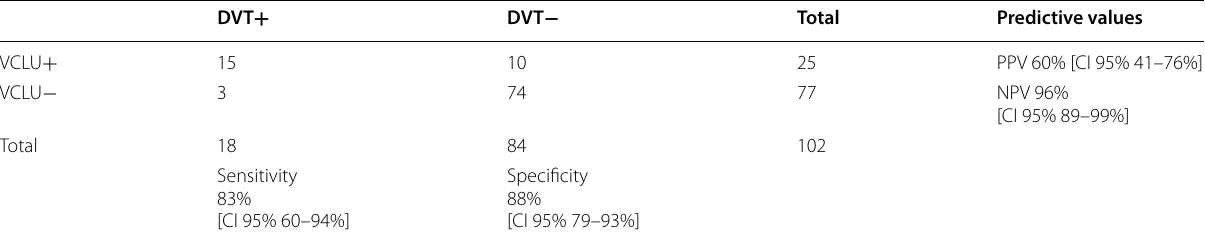
Table 2 Contingency table of diagnostic performances of venous limited compression ultrasonography in 102 patients suspected to have a DVT